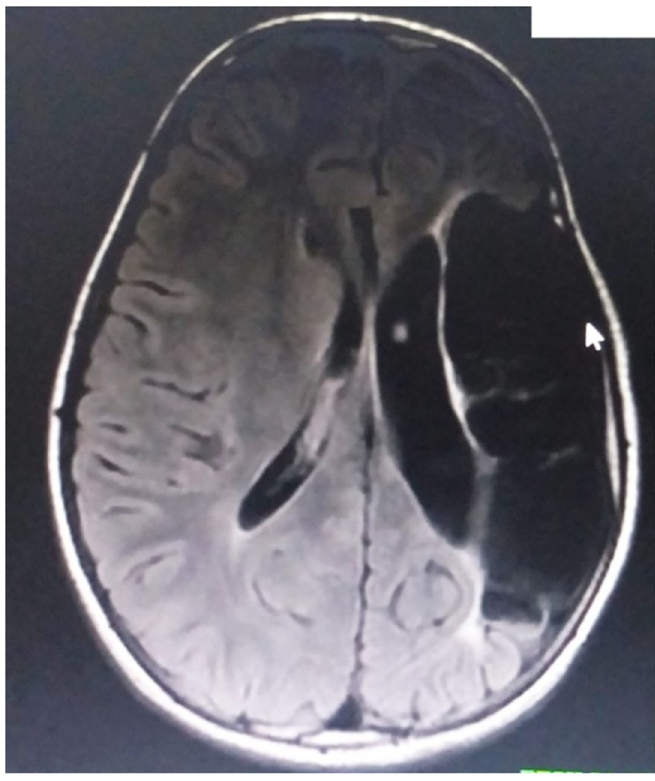
Fig 4. MRI of a 13 year old with right spastic hemiparesis. MRI of a 13 year old male patient born at term with right spastic hemiparesis (Case 20) showing cortical and subcortical atrophy with increased subarachnoid space and adjacent T2 hyperintensity; most likely due to a perinatal